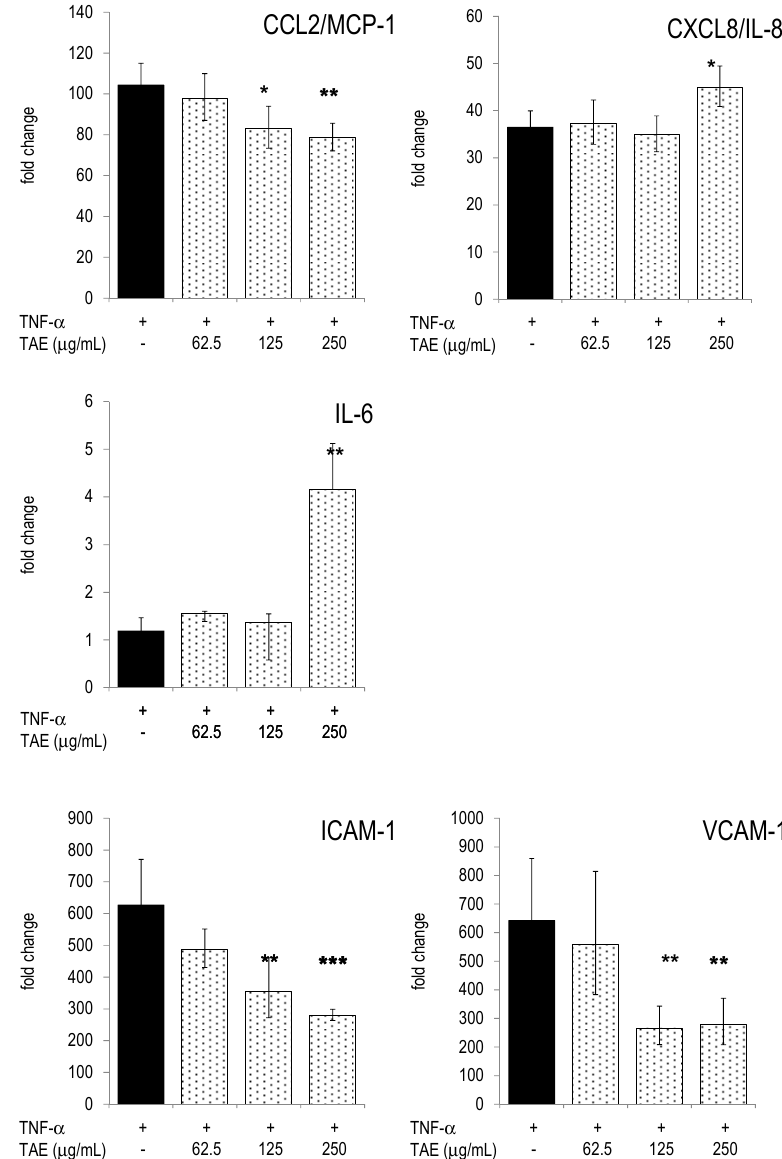
Figure 6. HUVECs were incubated with TAE, activated with 10 ng/mL TNF- α and cultured for 4 h. Gene expression was quantified by RT-PCR and the data expressed as fold change compared to levels observed in unstimulated cells. Mean ± standard errors of duplicates are given. * p < 0.05, ** p < 0.01, *** p < 0.001 ( vs. TNF- α -stimulated cells).